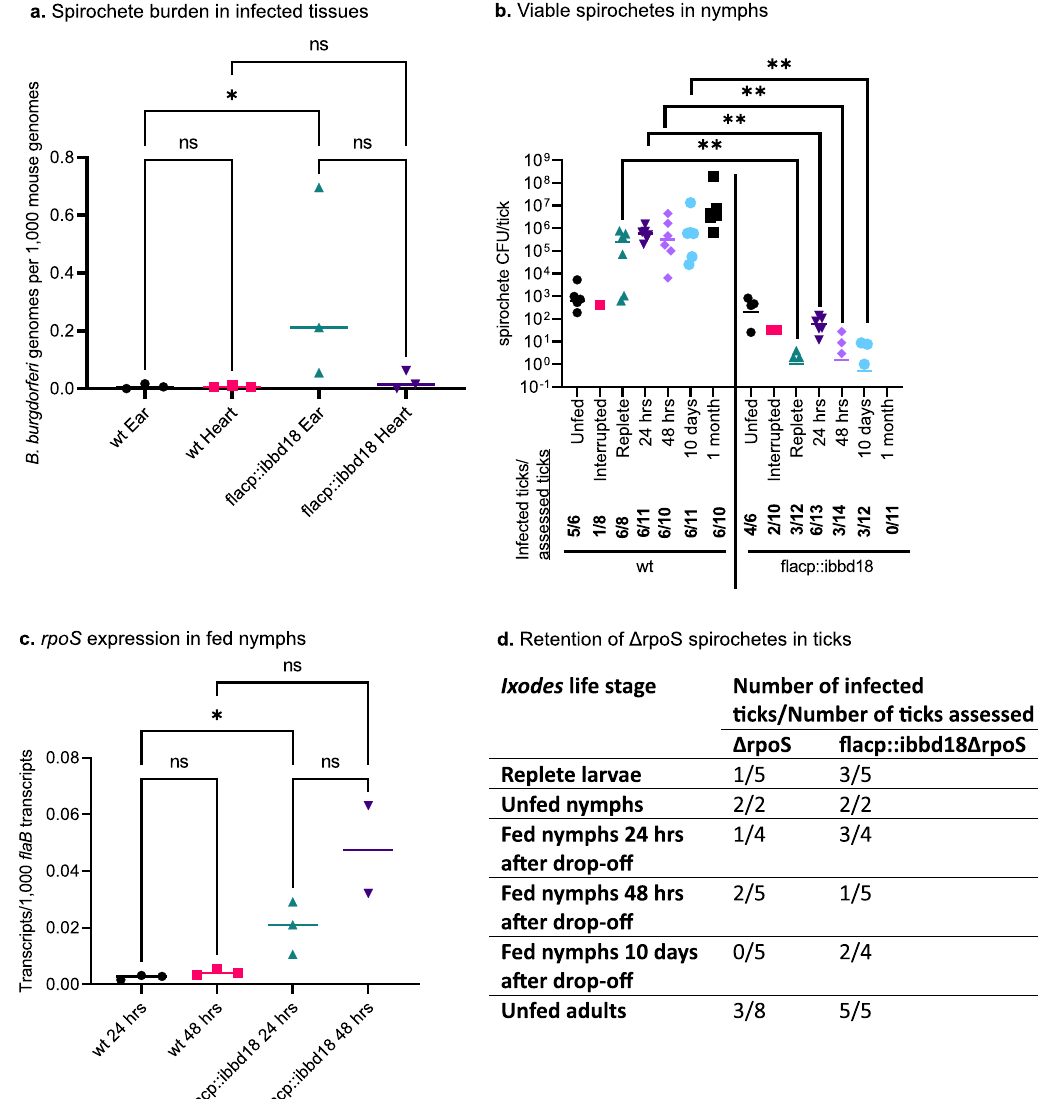
Fig. 8 | fl acp:ibbd18 spirochetes in infected mice and ticks. a qPCR of